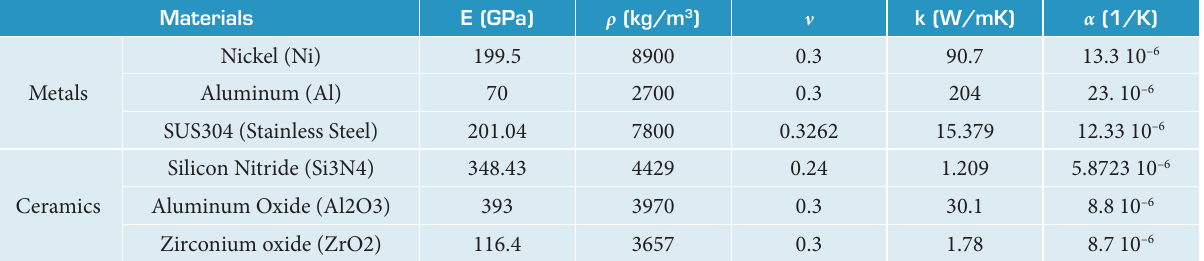
Table 3. Constituent material